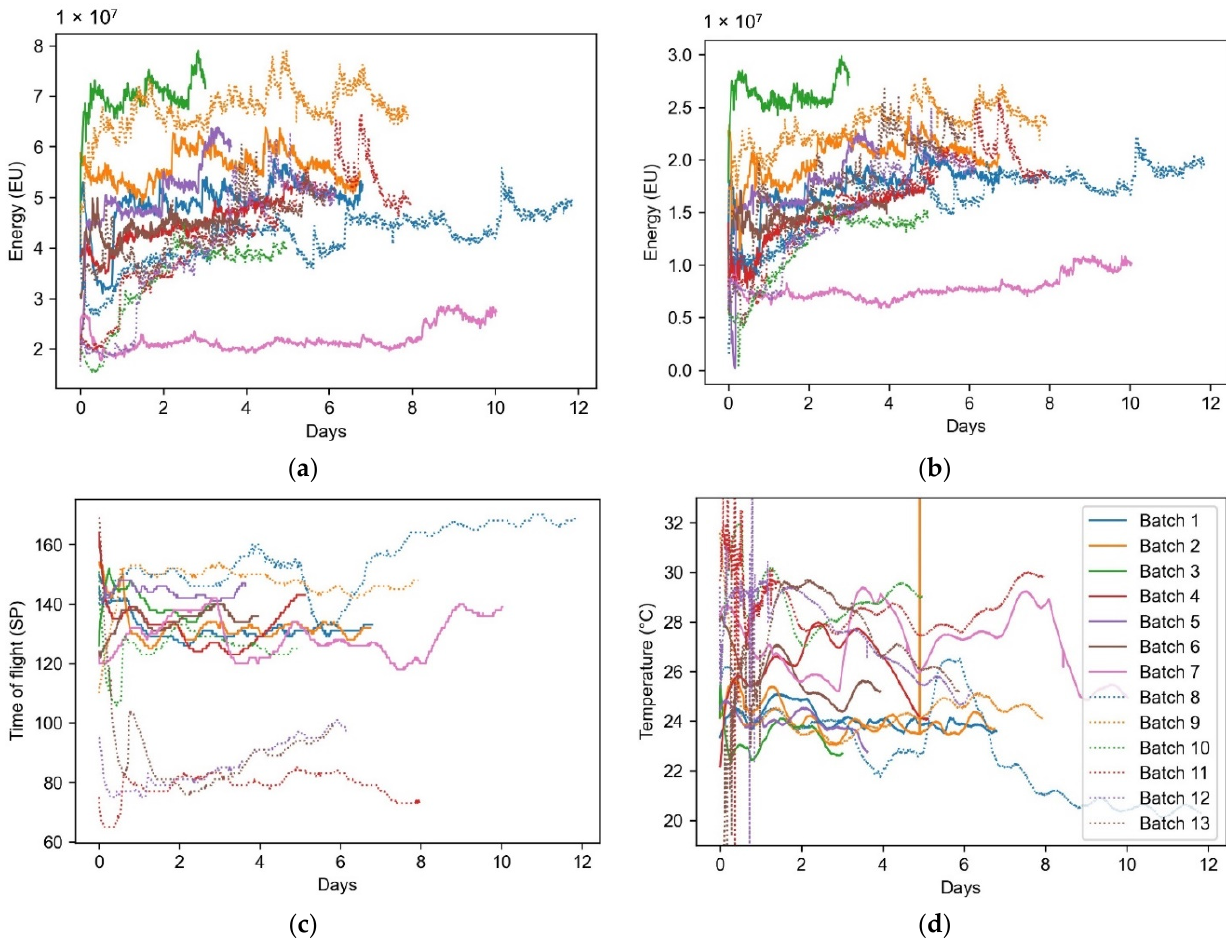
Figure 3. US waveform features for all fermentation batches: ( a ) The energy of the 1st reflection; ( b ) the energy of the 2nd reflection; ( c ) the time of flight for the 2nd reflection; ( d ) the process temperature.